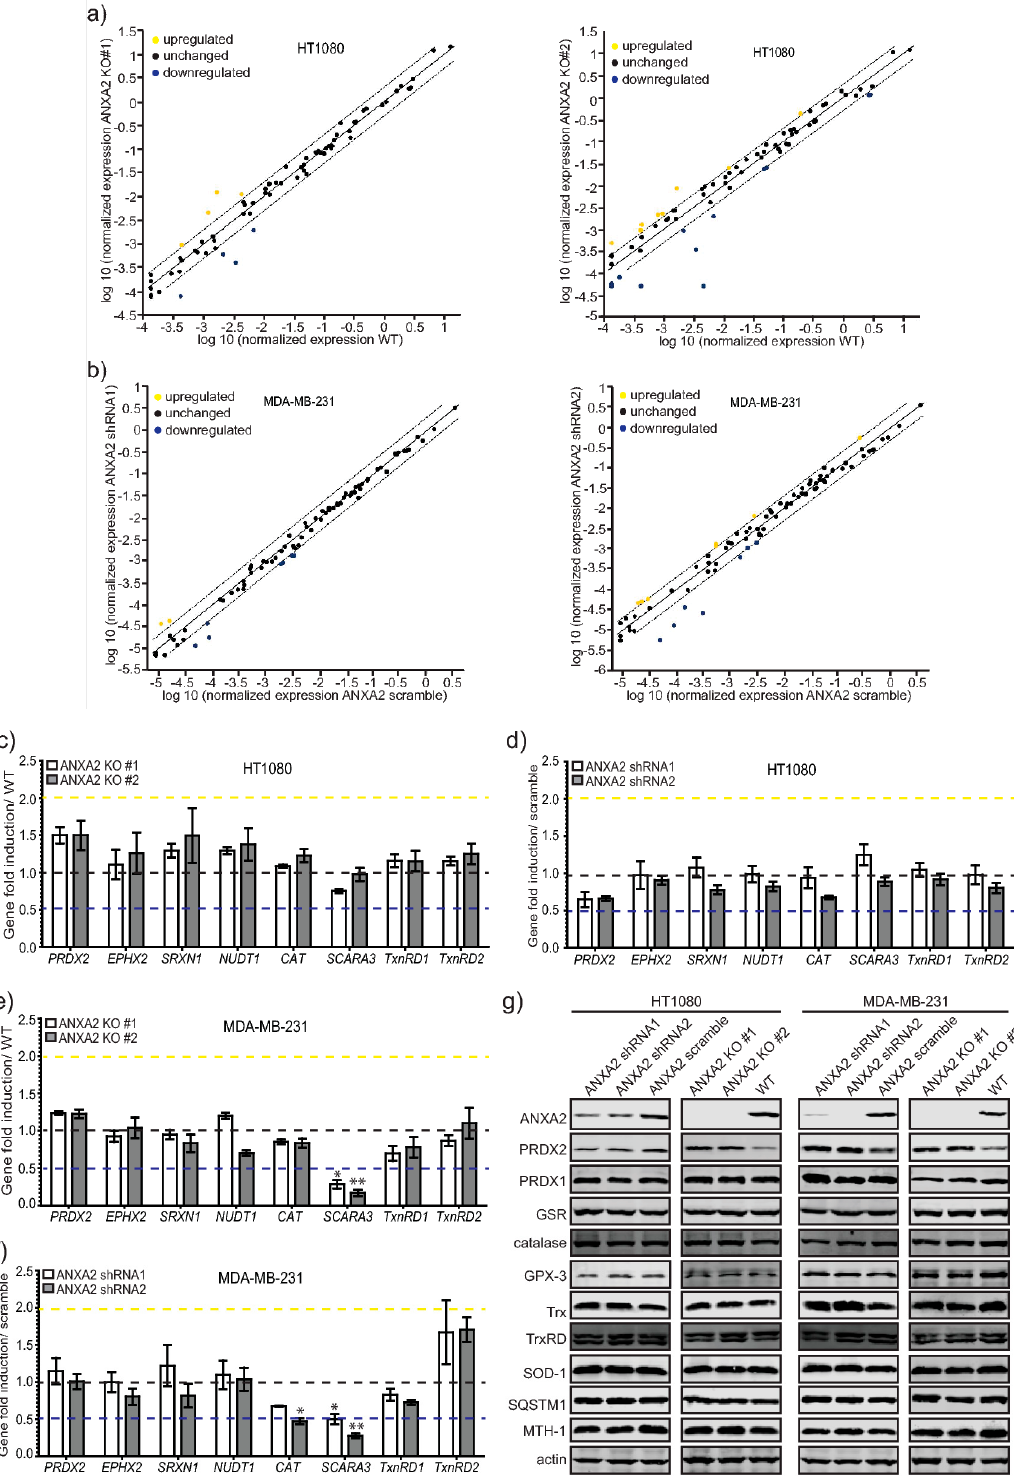
Figure 5. Analysis of ROS related genes and proteins in ANXA2 depleted versus control cancer cells. ( a ) HT1080 ANXA2 KO #1; ANXA2 KO #2 or WT or ( b ) MDA-MB-231 ANXA2 shRNA1; ANXA2 shRNA2 or ANXA2 scramble cells were plated in 100 mm plates for 48 h. After what RNA extraction was performed using the RNeasy mini kit (Qiagen, Manchester, UK) according to the manufacturer ′ s instructions. A panel of 86 ROS dependent genes was analysed using the RT² Profiler™ PCR Array